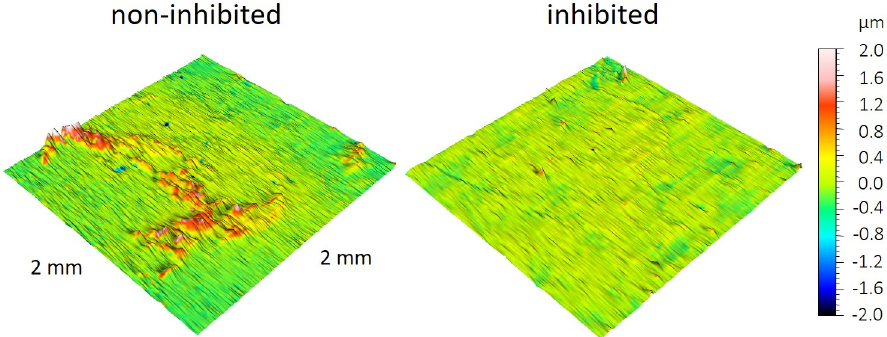
Figure 10. 3D ‐ profiles of the noninhibited and 2PhI ‐ inhibited copper samples after 31 days of Figure 10. 3D-profiles of the noninhibited and 2PhI-inhibited copper samples after 31 days of immersion in 3 wt.% NaCl solution. immersion in 3 wt.% NaCl